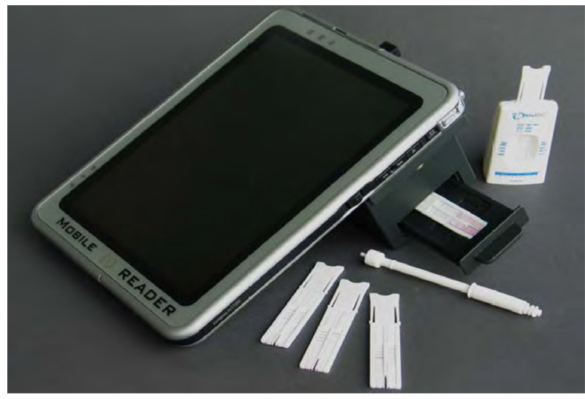
Figure 10. OralStat device